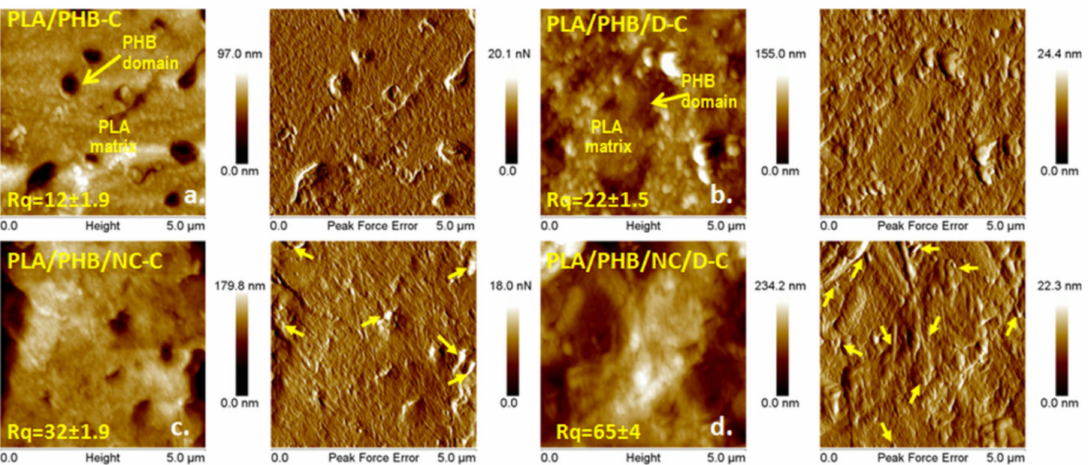
Figure 4. Height and peak force error images of the surface of PLA / PHB blends ( a , b ) and nanocomposite films ( c , d ), scan area of 5 µ m × 5 µ m; Root-mean-square roughness values added on each topographic